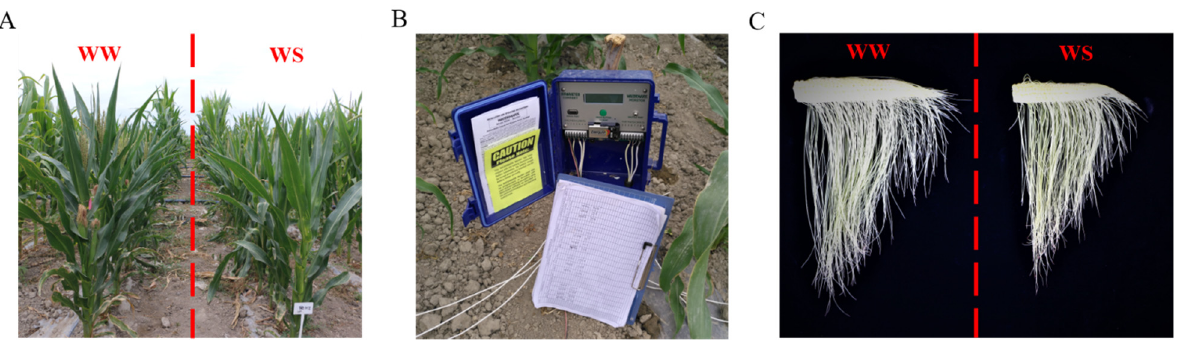
Figure 1. Soil moisture monitor and plant performance under different water treatment: ( A ) WA- TERMARK MONITOR installed in the field and connected to the sensor; ( B , C ) plant height and ear development of drought-sensitive lines under WW and WS